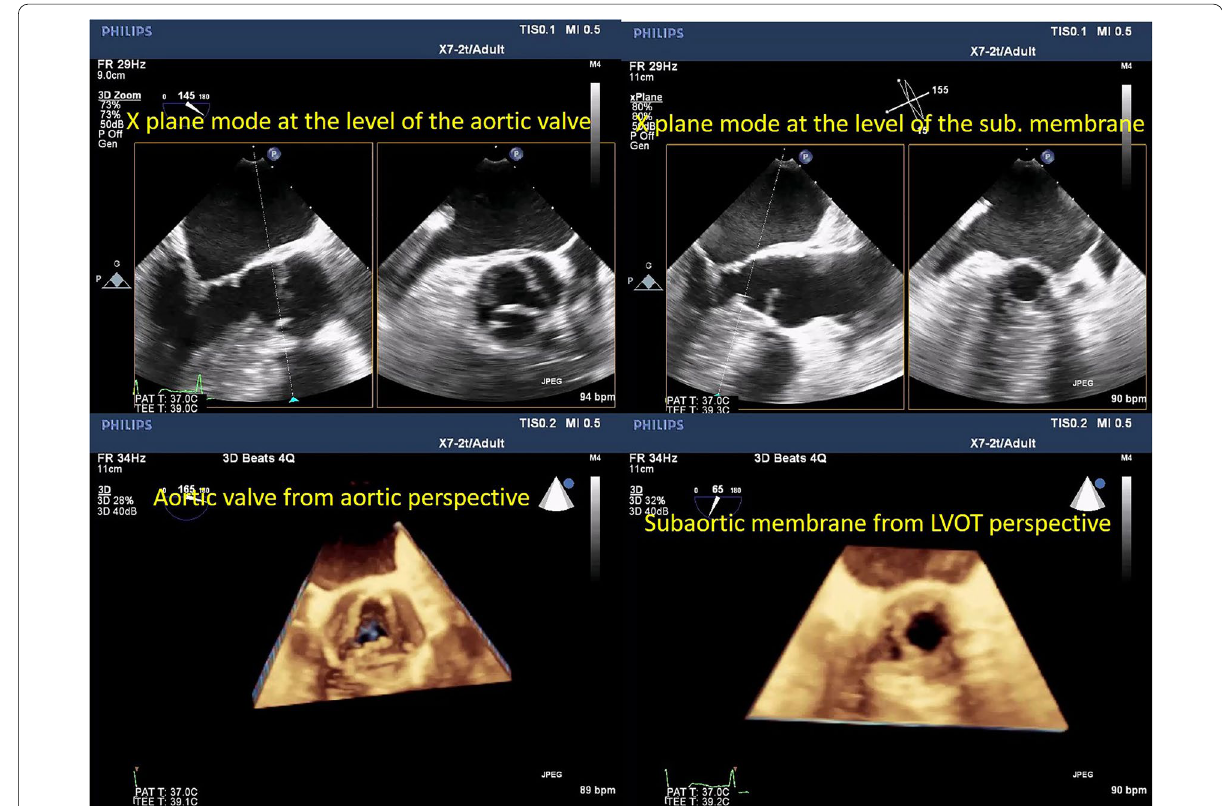
Fig. 11 Right upper panel, X‑plane mode of the aortic valve, the anatomical orifice of the aortic valve is seen in the perpendicular image. Left upper panel, X‑plane mode of the subaortic membrane (moving the reference line slightly to the right), the functional opening of the LVOT at the level of the subaortic membrane is clearly seen. Right lower panel, 3D‑zoomed volume of the aortic valve from the ascending aorta perspective shows the trileaflet valve with thickened cusps. Left lower panel, 3D‑zoomed volume (after cropping of the aortic valve plane) shows a circumferential muscular membrane with a circular